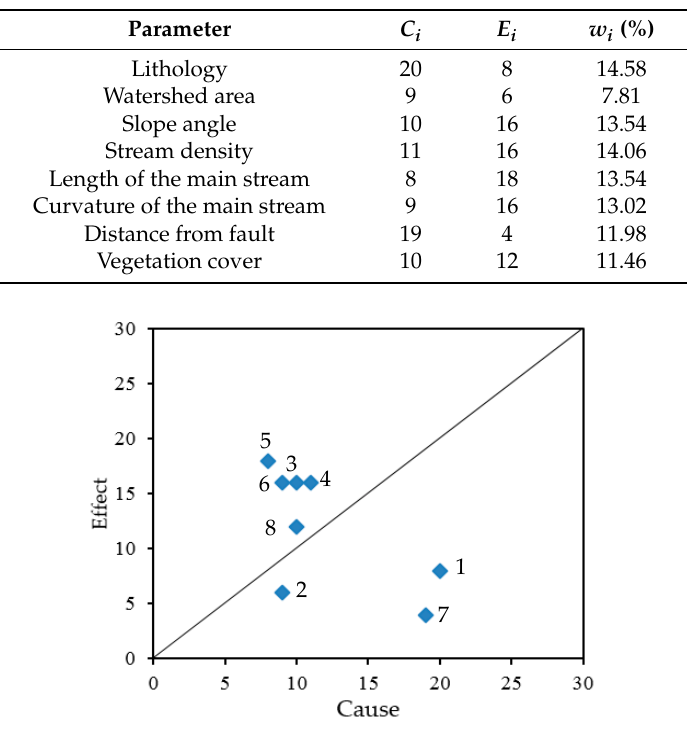
Table 4. Coordinates and weightings of influencing parameters.